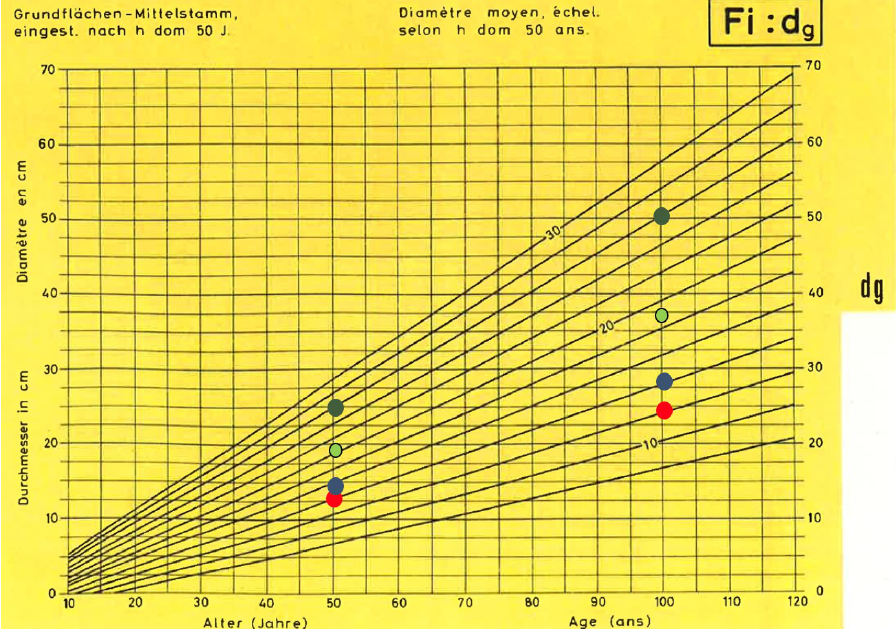
Figure 7. Comparison of the increments of the basal mean stem (dg) of spruce according to the Swiss yield table [52] with integration of the BHD increments resulting from the Swiss NFI data. The red dots stand for the subalpine altitudinal stage, blue stand for high montane, light green upper/lower montane, and dark green stands for the submontane/colline altitudinal